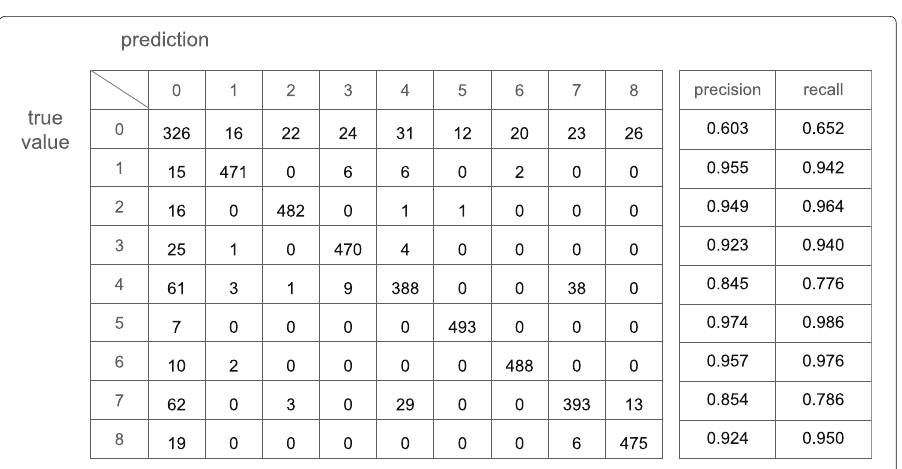
Fig. 15 The confusion matrix is from the LSTM model with opening, high, low, and closing prices (OHLC) feature set. The accuracy is 88.58% on average